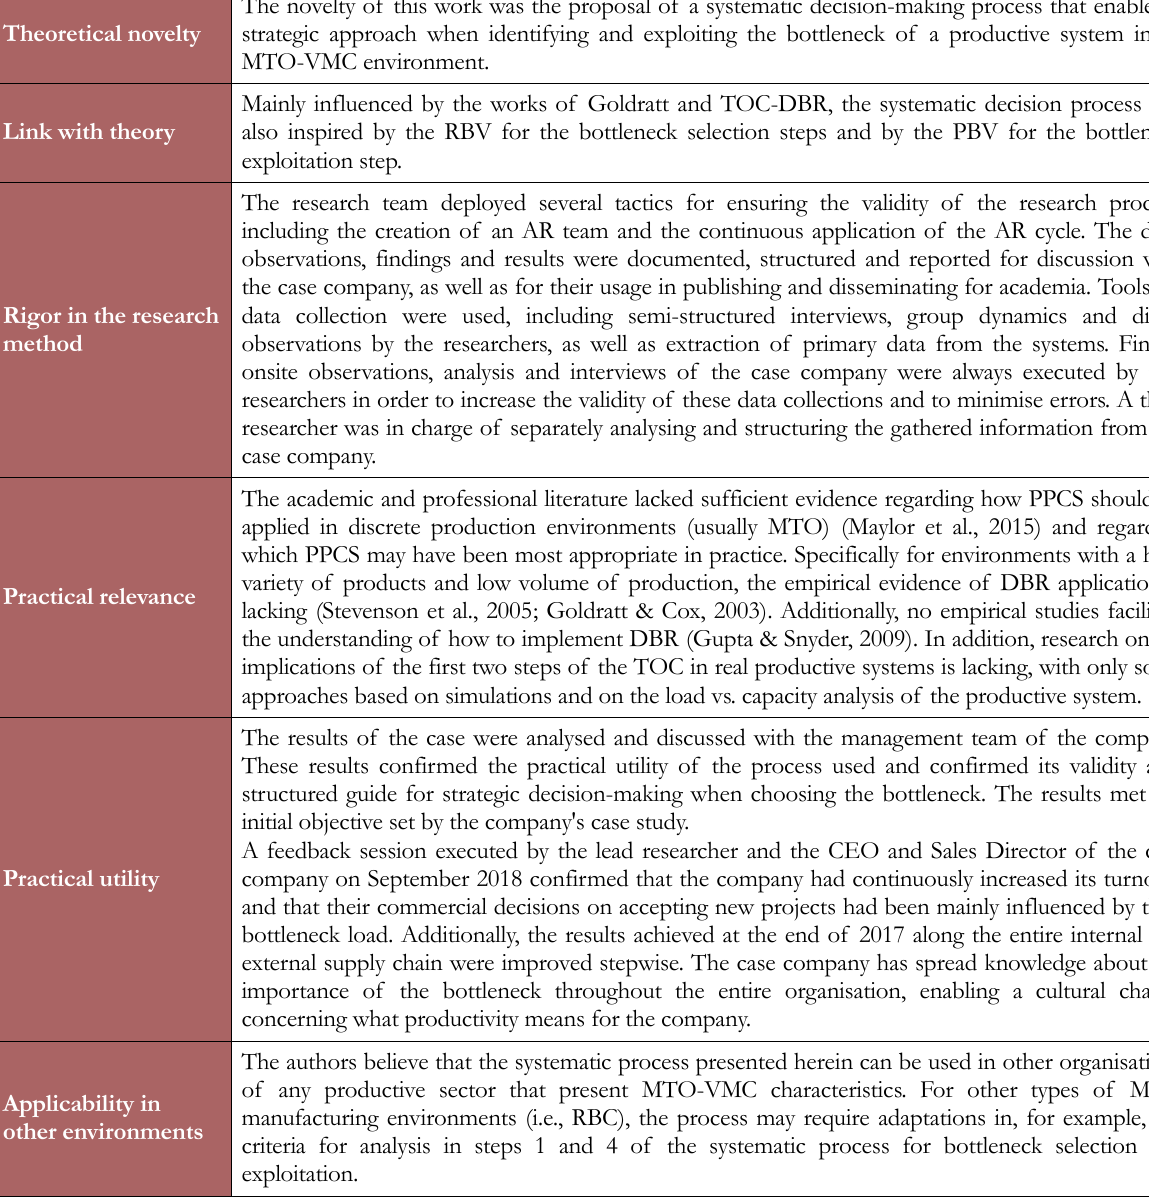
Table 10. Quality criteria for the research